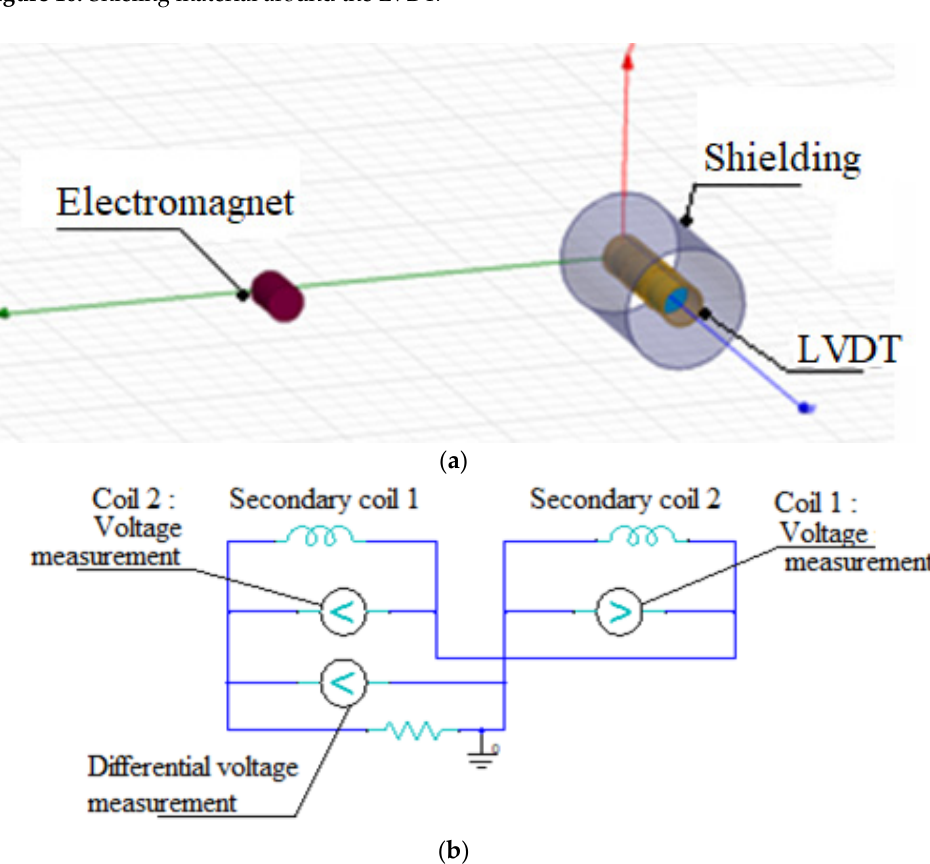
Figure 17. ( a ) FEA model of LVDT and electromagnet. ( b ) Electrical circuit in ANSYS Maxwell.